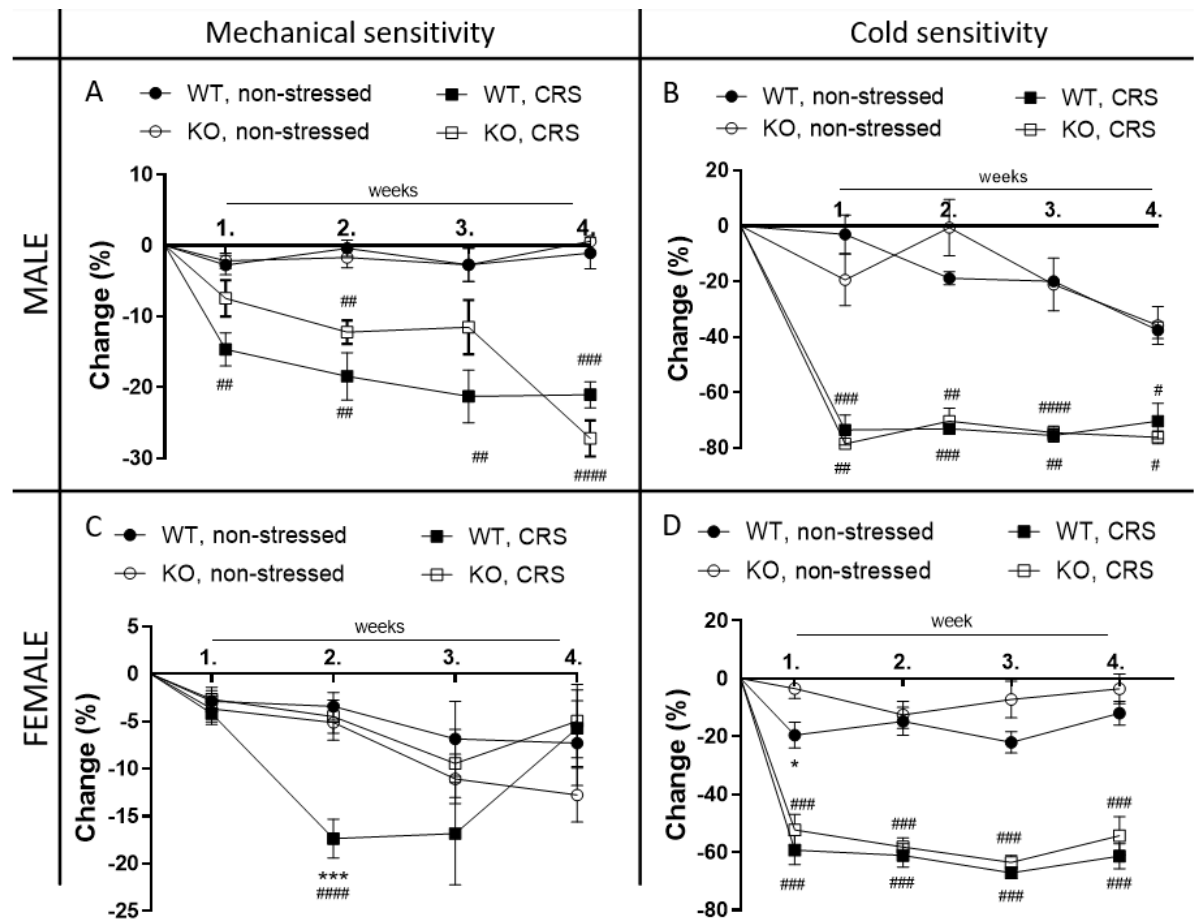
Figure 2. Effects of chronic restraint stress (CRS) on nociceptive behaviors of wild-type (WT) and Interleukine-1 knock-out (KO) mice. Male ( A ) and female ( C ) mechanonociceptive threshold and male ( B ) and female ( D ) cold tolerance (paw withdrawal latency) changes are presented compared to the baseline threshold. Data are presented as the means ± SEM ( n = 4–19); two-way repeated measurement analysis of variance (ANOVA), followed by Tukey’s tests; *** p < 0.001 vs. KO stressed group; * p < 0.05 vs. KO non-stressed group; # p < 0.05, ## p < 0.01, ### p < 0.001, #### p < 0.0001 vs. respective non-stressed groups.